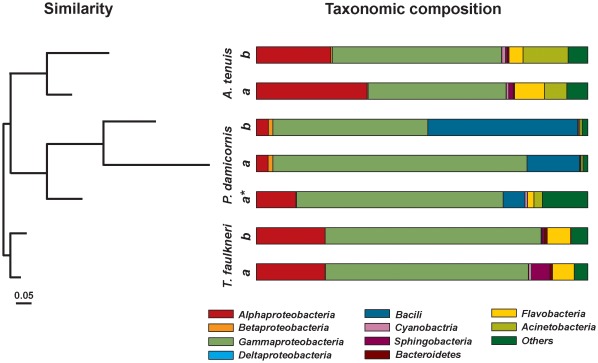
Bacterial 16 S rRNA gene sequences retrieved from three coral species before (b), after (a) coral spawning and after planulation (a*). Replicate samples were pooled and dominant affiliations were grouped at the class level. The similarity tree was done using the neighbour-joining method and the Bray-Curtis algorithm (n = 1000 replications). Note: due to failure in amplification P. damicornis and T. faulkneri are represented by one sample per sampling point and one sample after coral spawning, respectively.